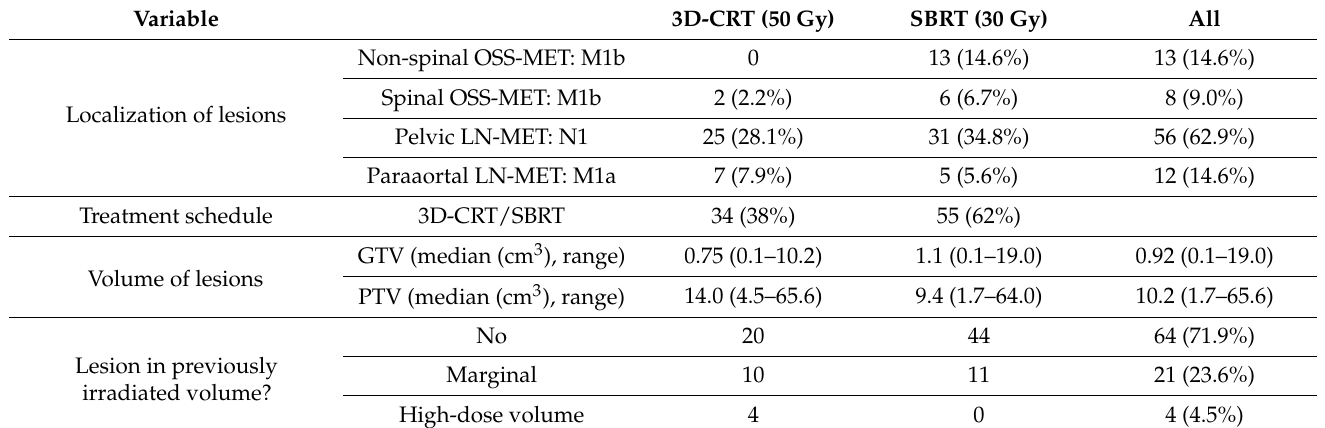
Table 2. Baseline characteristics of metastatic lesions ( n = 89).